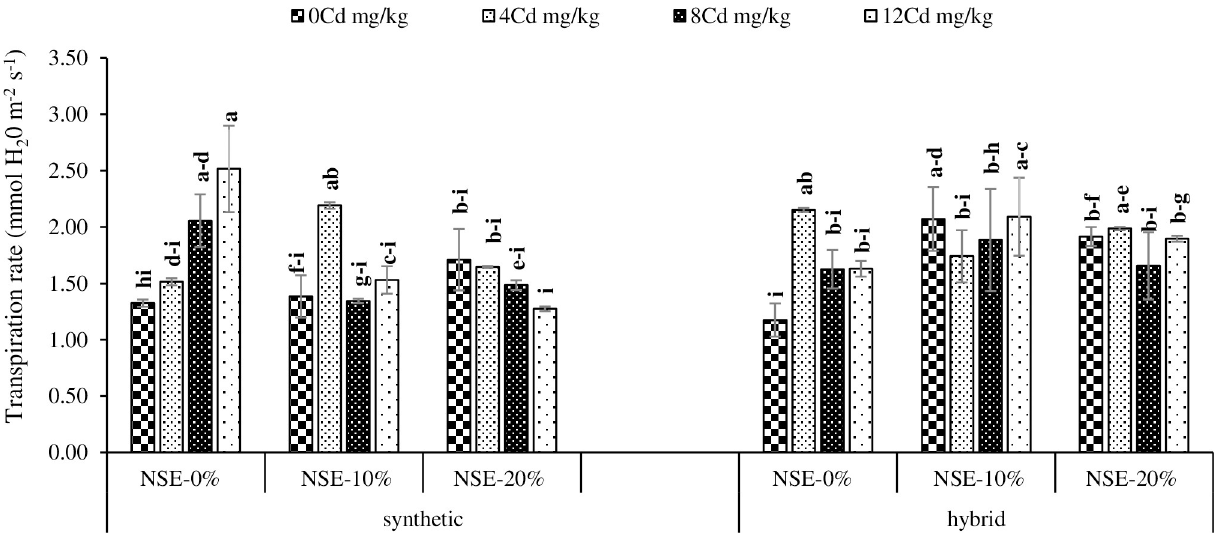
Fig 2. Effect of different concentrations of Nigella sativa seed extracts on transpiration rate ± standard errors on different maize genotypes grown under various cadmium concentrations. Means sharing the same case letter for a parameter did not differ significantly from each other at p > 0.05. Here, NSE = N . sativa seed extract; DAS = days after